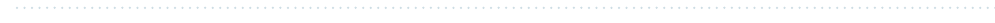
Figure 1. Illustration of ROIs and corresponding histological findings in representative cases of non- muscle invasive UTUC and muscle invasive UTUC. ( A – C ) In non-muscle invasive UTUC, unenhanced ( A ), nephrogenic ( B ) and excretory ( C ) images are shown synchronically to detect tumor in the renal pelvis, and the ROI (red oval) was determined. ( D ) The histogram of CT value in HU in the tumor revealed a shape with almost a single peak. ( E ) Hematoxylin and eosin staining showed typical non-invasive papillary urothelial carcinoma. ( F ) Image analysis to estimate the amount of stromal components in tumor tissue using Image J software. An appropriate threshold was drawn to distinguish tumor cells and stromal components. ( G – I ) In muscle invasive UTUC, the ROI was determined with unenhanced ( G ), nephrogenic ( H ) and excretory ( I ) images. ( J ) The histogram revealed a shape with a broad base and multiple peaks. ( K ) Hematoxylin and eosin staining showed muscle invasive urothelial carcinoma. ( L ) Image analysis using Image J software. ROI = region of interest, UTUC = upper tract urothelial carcinoma, CT = computed tomography, HU = Hounsfield unit, SD = standard deviation, TA = texture